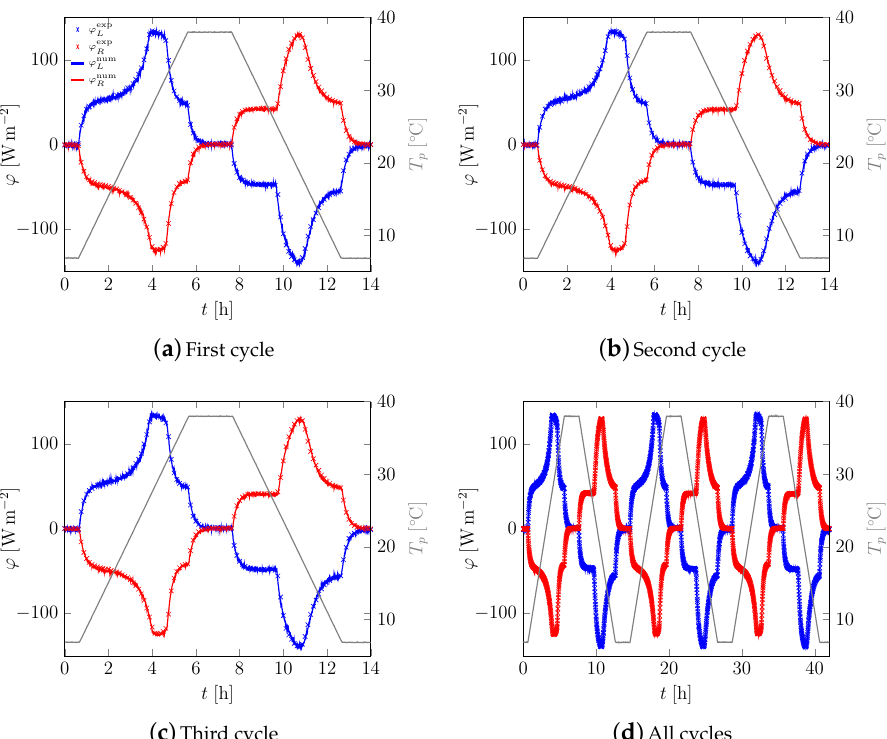
Figure A11. 22.1% w -PCM mortar: comparisons of the experimental fluxes with the numerical ones after identification for the 5h heating/cooling ramp